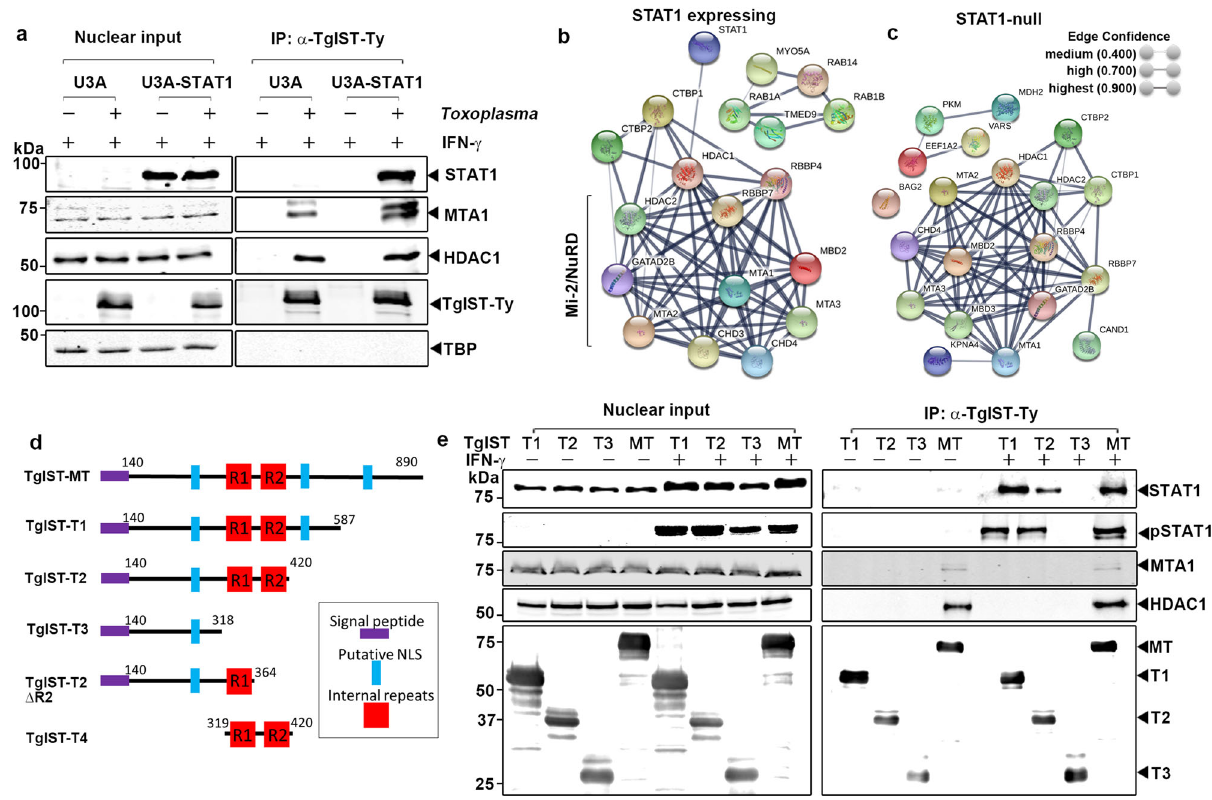
Fig. 1 Different domains of TgIST interact with phosphorylated STAT1 dimers and the Mi-2/NuRD complex. a Western blot analysis of host proteins following immunoprecipitation (IP) of TgIST-Ty from U3A (STAT1-null) or U3A-STAT1 (STAT1 complemented) cells that were infected with T. gondii expressing TgIST-Ty vs . mock for 16 h followed by treatment of 100 U/mL IFN- γ for 60 min. Two core components of the Mi-2/NuRD complex, metastasis- associated protein (MTA1) and histone deacetylase 1 (HDAC1), were co-precipitated with TgIST-Ty. TATA-binding protein (TBP) was used as a negative control. Representative blots of two independent experiments with similar results are shown here. b , c TgIST-associated host proteins identi fi ed by mass spectrometry analysis and visualized by STRING protein interaction network analysis. Immunoprecipitated TgIST-Ty from U3A-SAT1 cells (STAT1 expressing) and U3A cells (STAT1 null) were eluted from Dynabeads G and subjected to MS/MS analysis. STRING network derived from three experiments ( ≥ 2 peptide with 99% identity) including proteins with signi fi cant enrichment ( P ≤ 0.05 unpaired Student ’ s t -test, two-tailed). d Schematic representation of the mature form of TgIST (TgIST-MT) and truncated constructs (TgIST T1-T4) used in this study. The signal peptide (purple), putative nuclear localization sequences (NLS) (blue), and internal repeats R1 and R2 (red) are represented. e Western blot analysis of TgIST-Ty immunoprecipitation (IP) from TgIST transfected HEK293T cells. Cells were transfected with plasmids expressing different TgIST domains shown in d (i.e., TgIST-T1, -T2, -T3) or mature TgIST (TgIST-MT) for 23 h, then treated ± IFN- γ (100 U/mL) for additional 60 min prior to nuclear extract preparation. performed using an Odyssey infrared imager. Representative blots of two independent experiments with similar results are shown here. Source